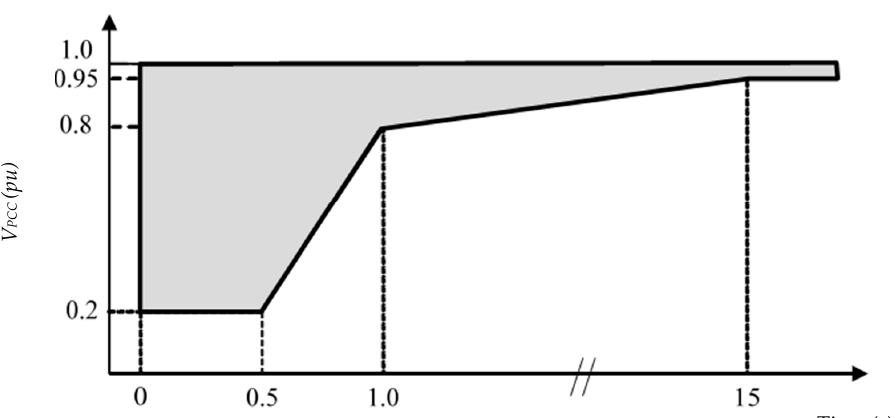
Figure 2. Fault ride-through (FRT) profile according to the Spanish grid code. Reproduced from reference [23].